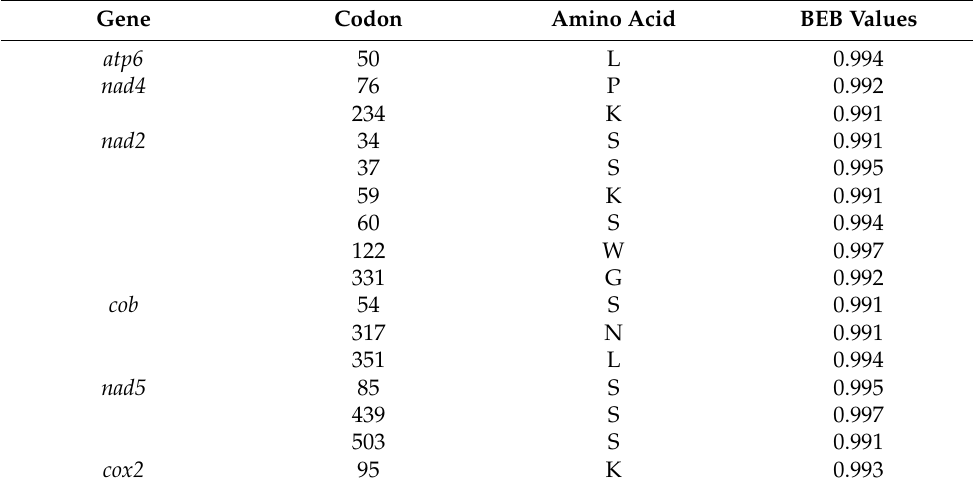
Table 2. Possible sites under positive selection in the deep-sea mussels. Gene Codon Amino Acid BEB